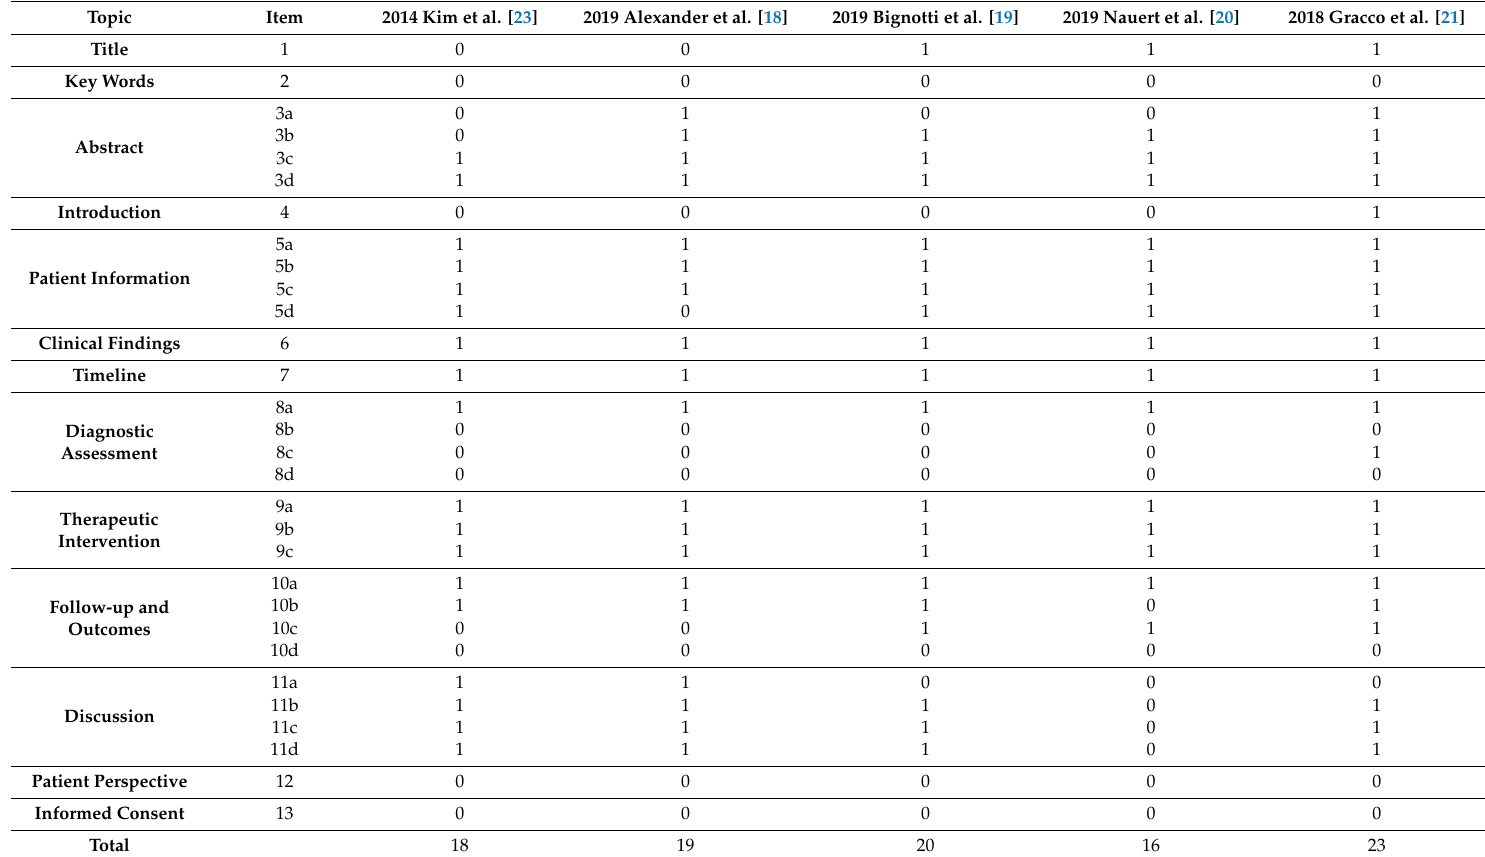
Table A3. CAse REport (CARE)